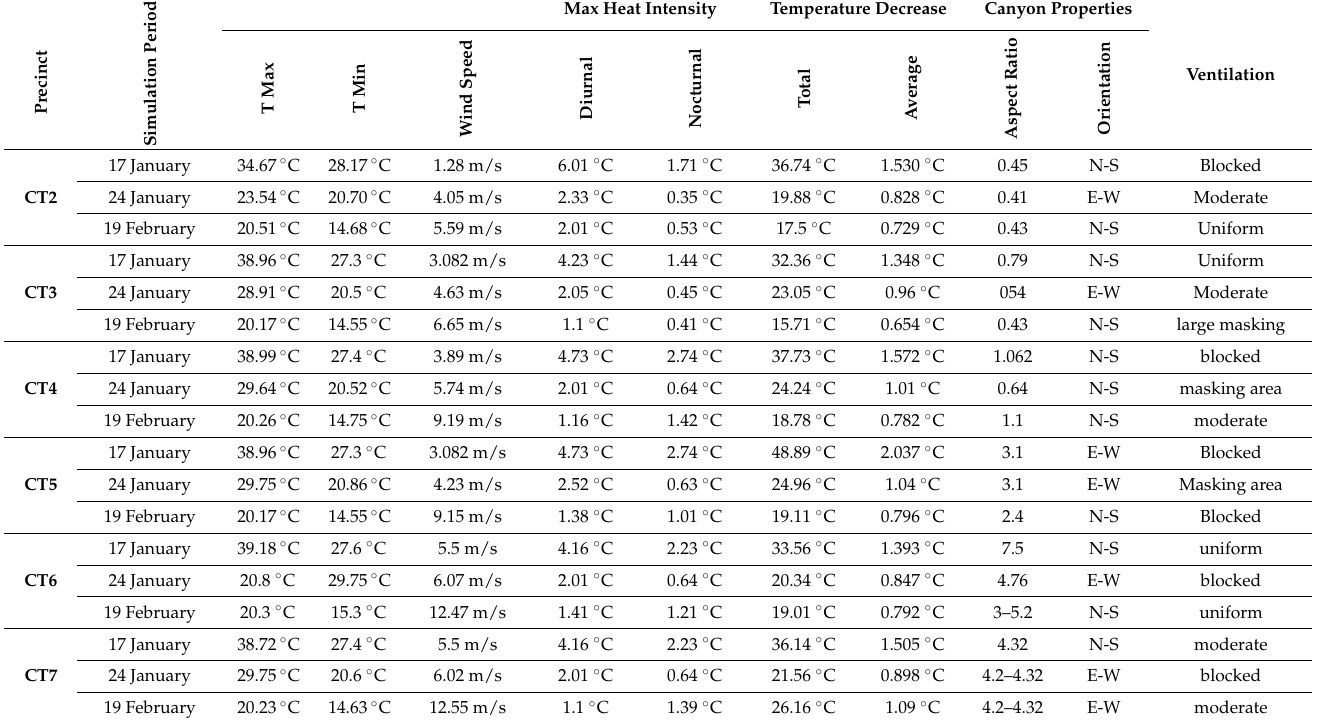
Table 7. Summary of the main climatological variables extracted from the heat map in all compact